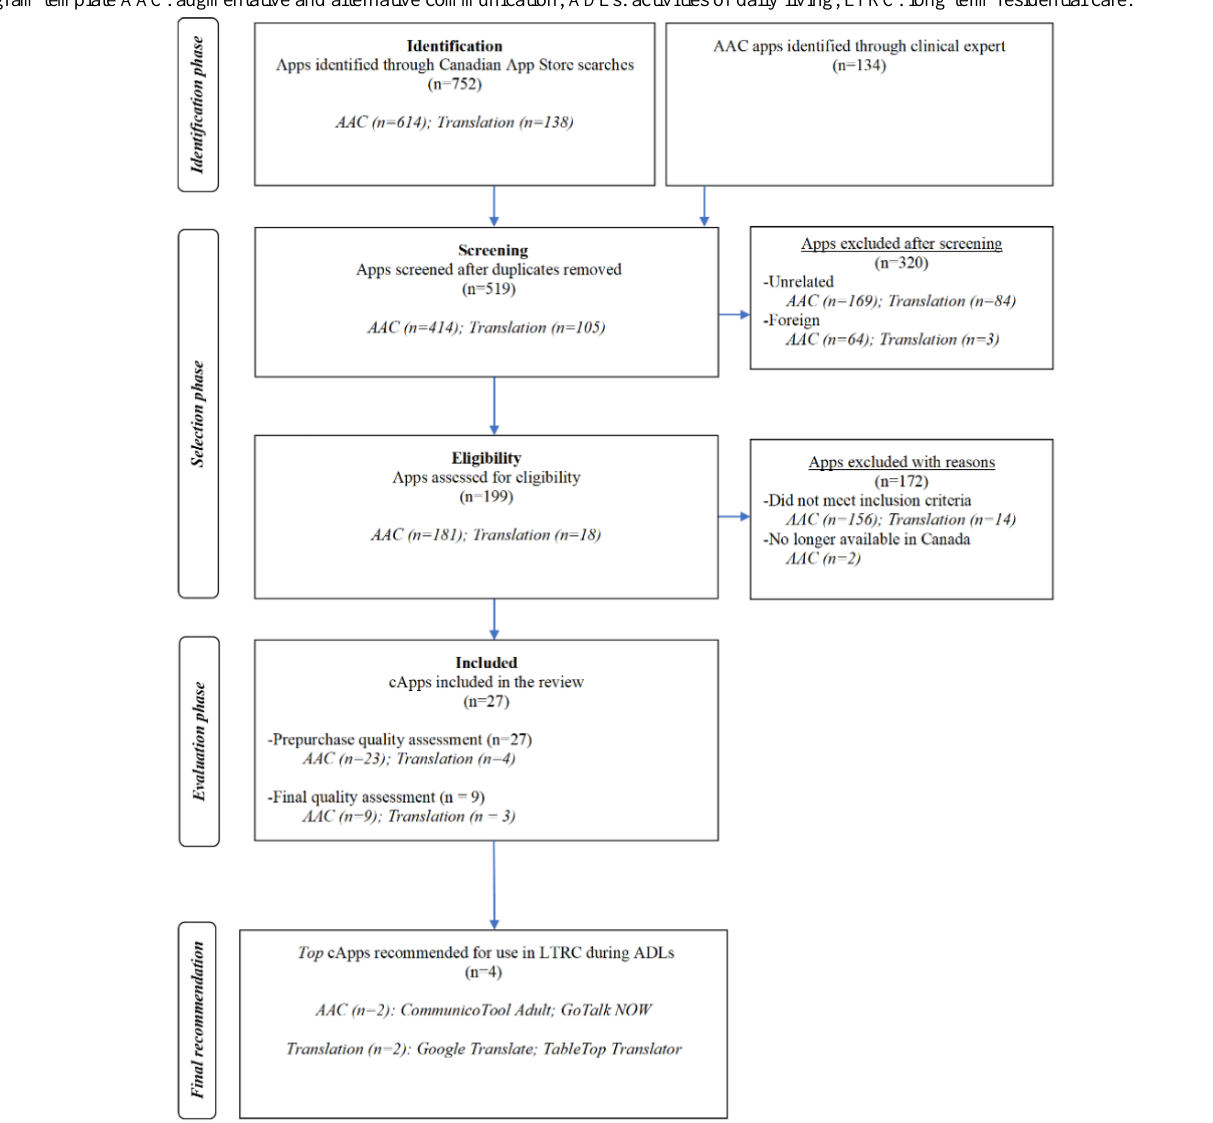
Figure 2. Flow diagram summarizing the results of the identification, selection, evaluation, and final recommendation phases involved in the 2015 communication app review. The presentation of results was guided by the Preferred Reporting Items for Systematic Reviews and Meta-Analyses flow diagram template AAC: augmentative and alternative communication; ADLs: activities of daily living; LTRC: long-term residential